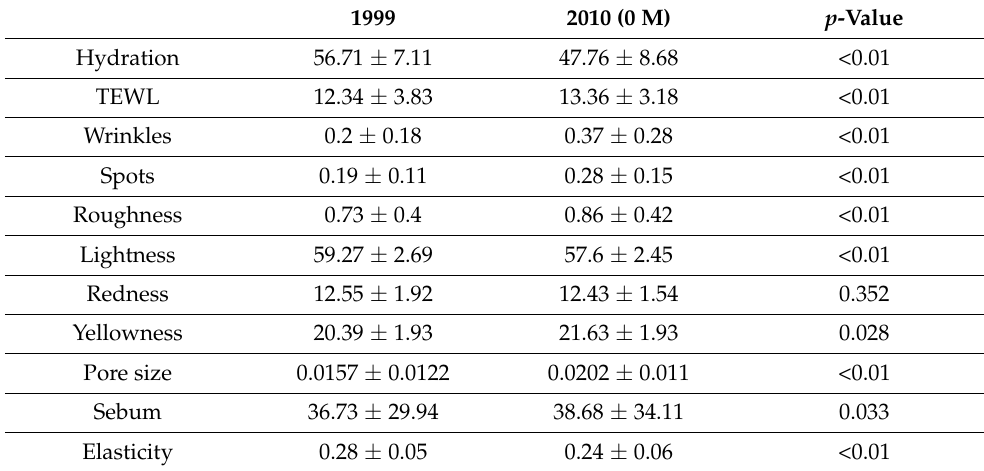
Table 1. Changes in skin aging parameters between 1999 and 2010 (0